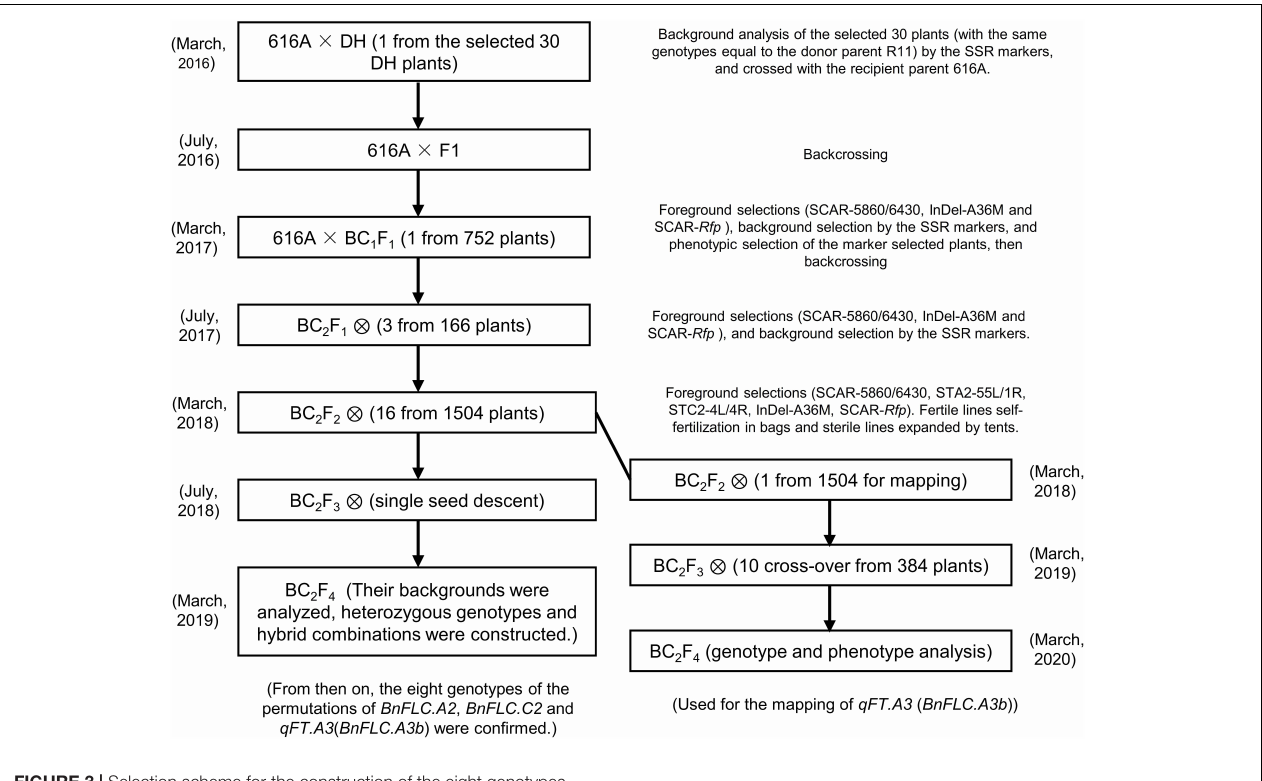
FIGURE 3 | Selection scheme for the construction of the eight genotypes. TABLE 1 | Allele permutations, recurrent genome recoveries (Khan et al., 2018), and flowering time comparison of the eight